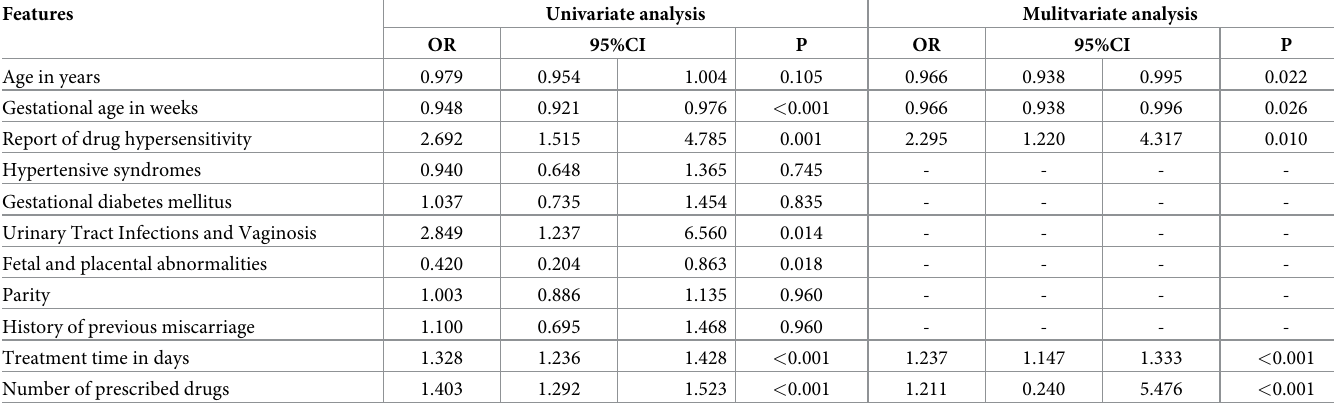
Table 4. Risk factors associated with the occurrence of Drug-Related Problems (DRPs) in hospitalized pregnant women.